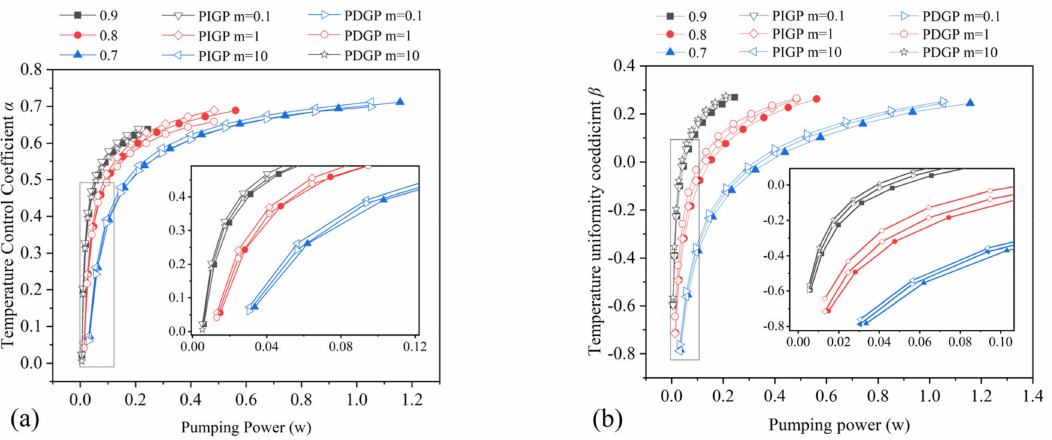
Figure 14. ( a ) Temperature control coefficient α , ( b ) temperature uniformity coefficient β (with AFHS with gradient porosity designed in the Z -axis